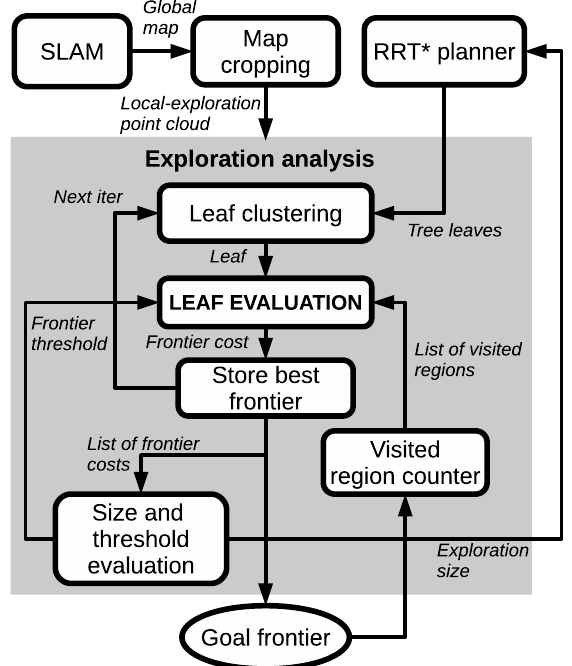
Figure 3. General diagram of the exploration